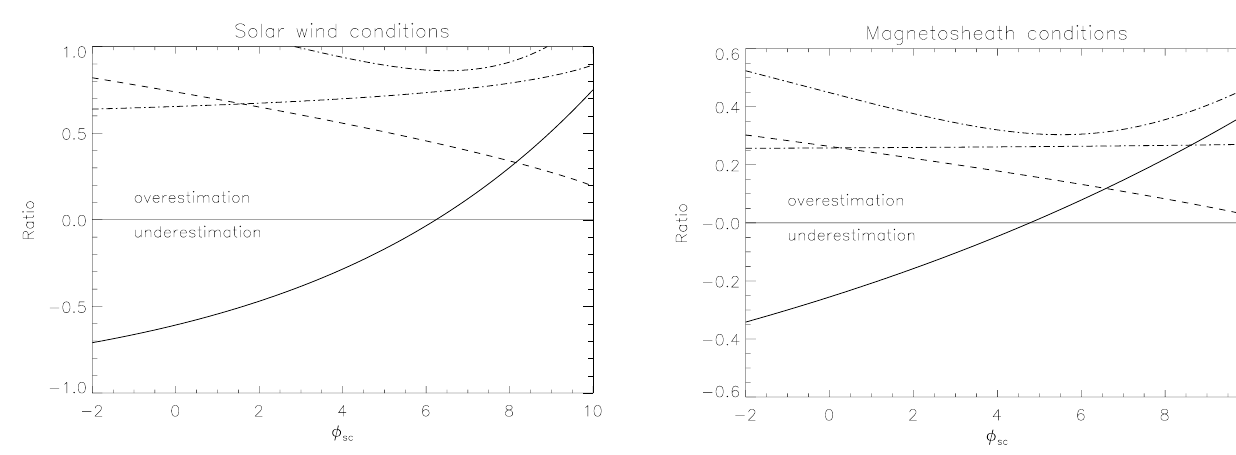
Fig. 3. Estimation ratios (relative differences between measured and corrected moments) in the solar wind case: plasma density ratio r N (solid line), bulk speed ratio r v (dashed line), temperature ratio r T (dot-dashed line). The upper curve is the estimation index I e .